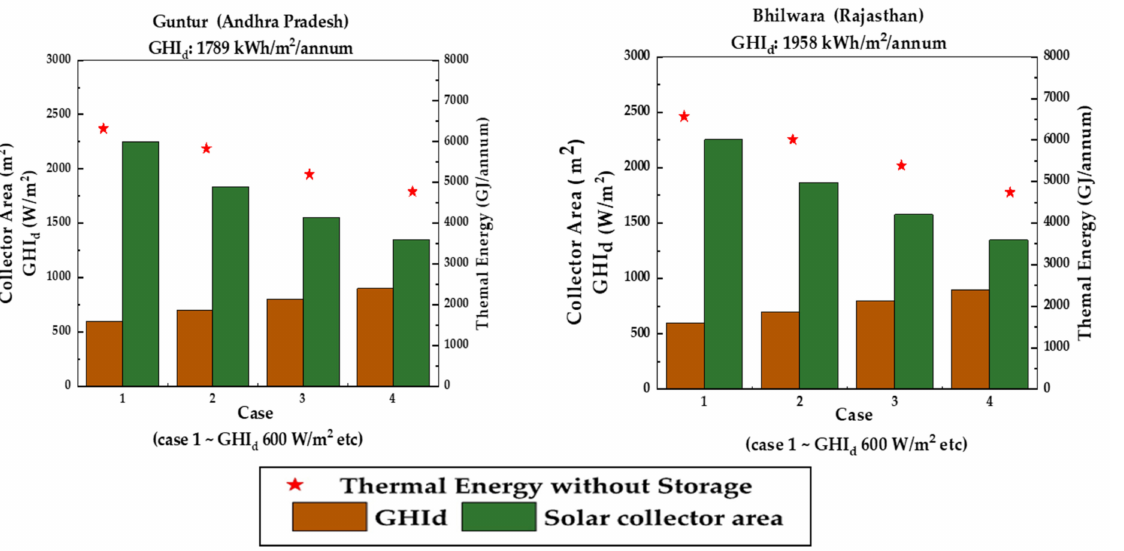
Figure 2. Variation of thermal energy with changing GHI d values for each of the selected